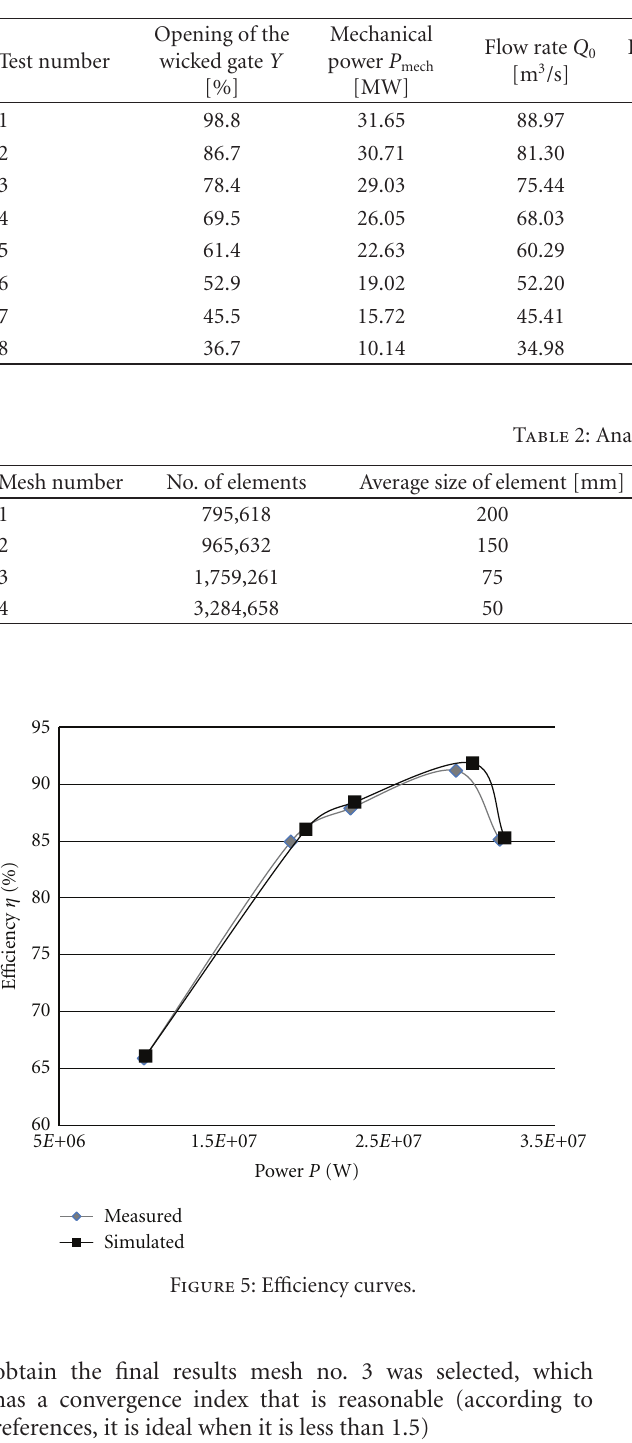
Table 1: Summary of measurements.